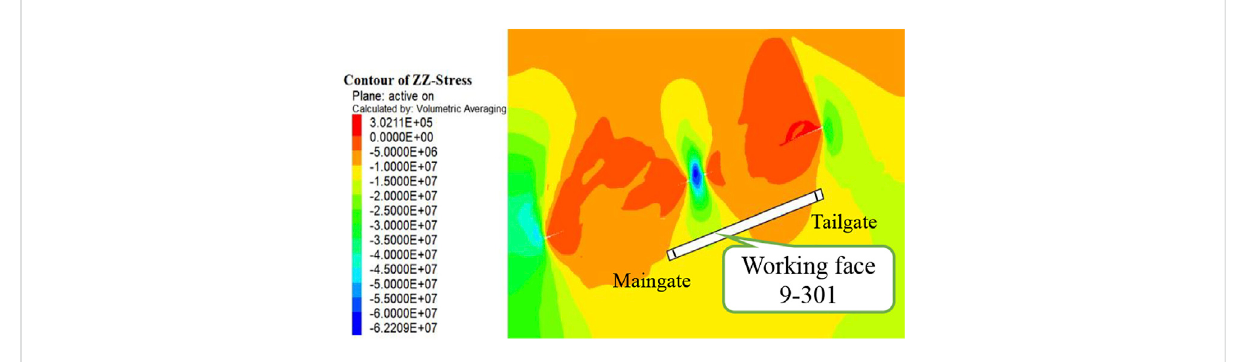
FIGURE 5 Stress distribution of the surrounding rock before mining in the 9-301 working